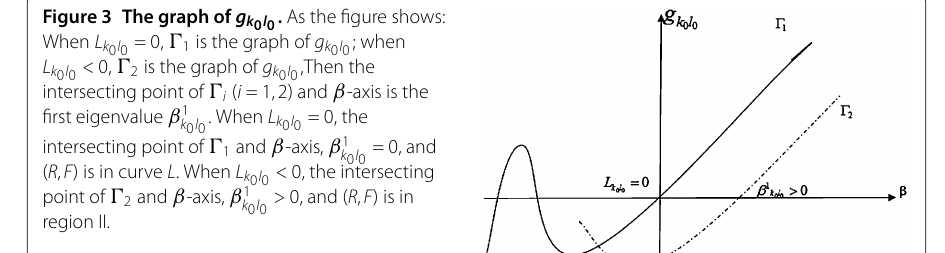
Figure 4 The graph of L kl . The curl L kl passes through the point ( R 1 , F 1 ) and intersects with the R -axis at R C find that R C > R C 1